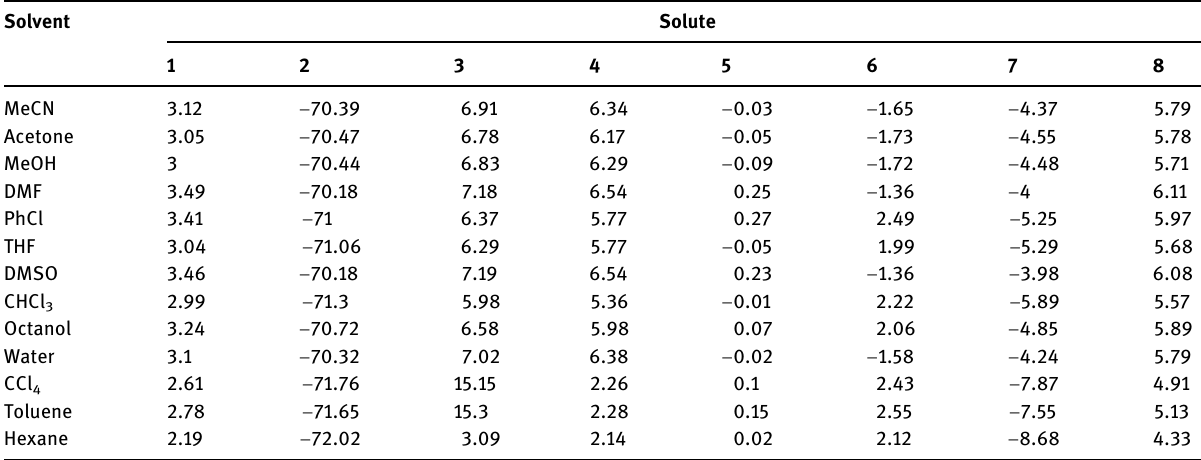
Table 12: Calculated di ff erences between values of λ max for azoles 1 – 8 at the MPW1PW91/6 - 311 ++ G ( 2d,3p ) //MPW1PW91/6 - 31G ( d,p ) level of theory in the PCM solvation model and the gaseous phase ( Δ λ max [ nm ])